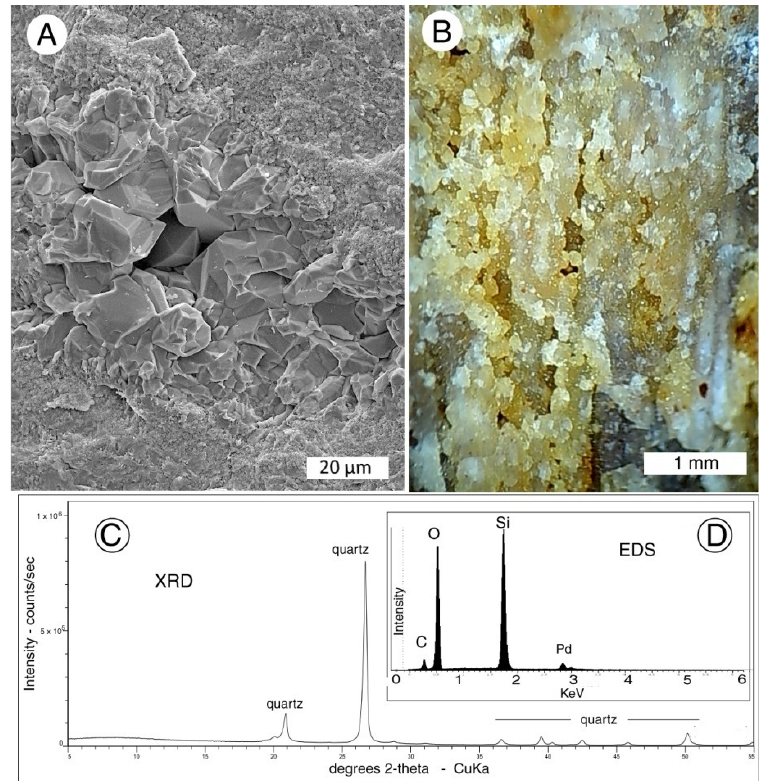
Figure 13. Sample S-1, an example of fossil wood that contains quartz as the only major constituent. ( A ) Scanning electron microscopy showing that vessels commonly contain quartz crystals, in contrast to the fine-grained quartz that has replaced surrounding tissue. ( B ) Low-magnification optical microscopy shows the replacement of individual wood cells by crystalline silica. ( C ) XRD pattern consists only of quartz peaks. ( D ) In the SEM/EDS spectrum, the small carbon peak is evidence that the fossil wood contains only a very small fraction of the original organic matter. The Pd peak is from metal applied to the SEM specimen to prevent electrical charging.